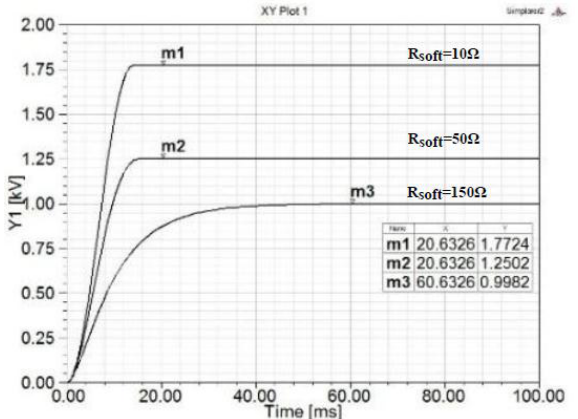
Fig. 6. The removing process of soft-start